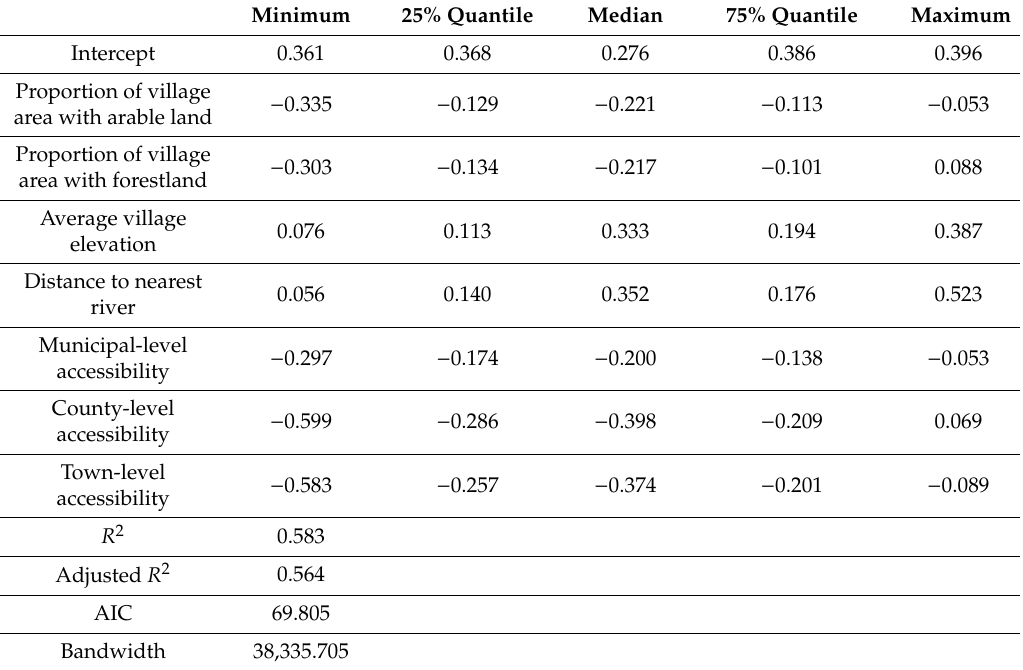
Table 3. Geographically weighted regression (GWR) summary statistics for local coe ffi